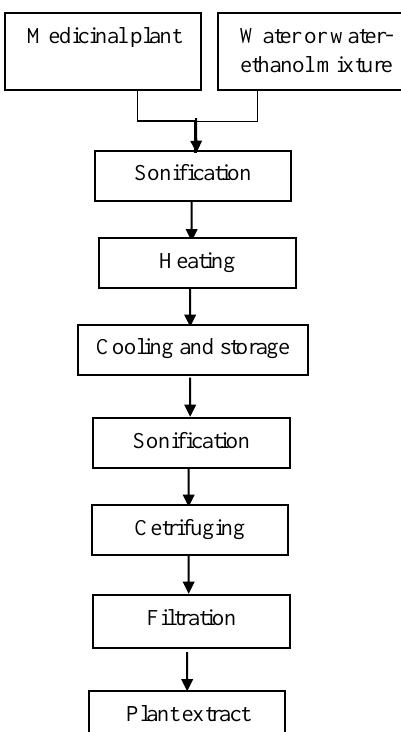
Figure 1. Scheme of water and water-ethanolic extract preparation.